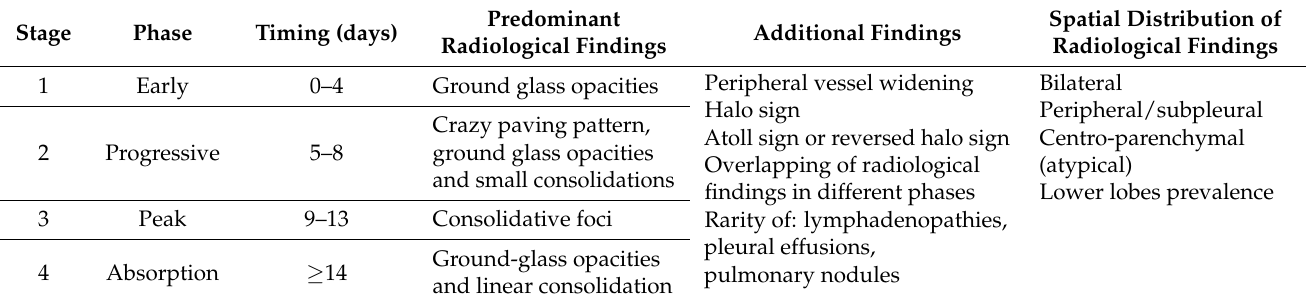
Table 1. COVID-19 pneumonia main radiological features, additional findings, and spatial distri- bution [19]. The table was reproduced from Guarnera, A.; Podda, P.; Santini, E.; Paolantonio, P.; Laghi, A. Differential diagnoses of COVID-19 pneumonia: the current challenge for the radiologist-a pictorial essay. Insights Imaging 2021 , 12 , 34 [32], under the terms and conditions of the Creative Commons Attribution (CC BY) license (http://creativecommons.org/licenses/by/4.0/) (accessed